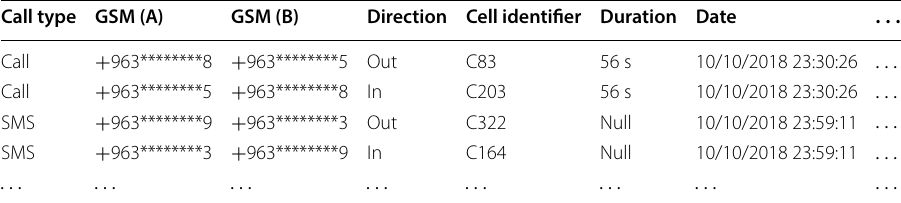
Table 1 CDR sample fields in Syriatel company